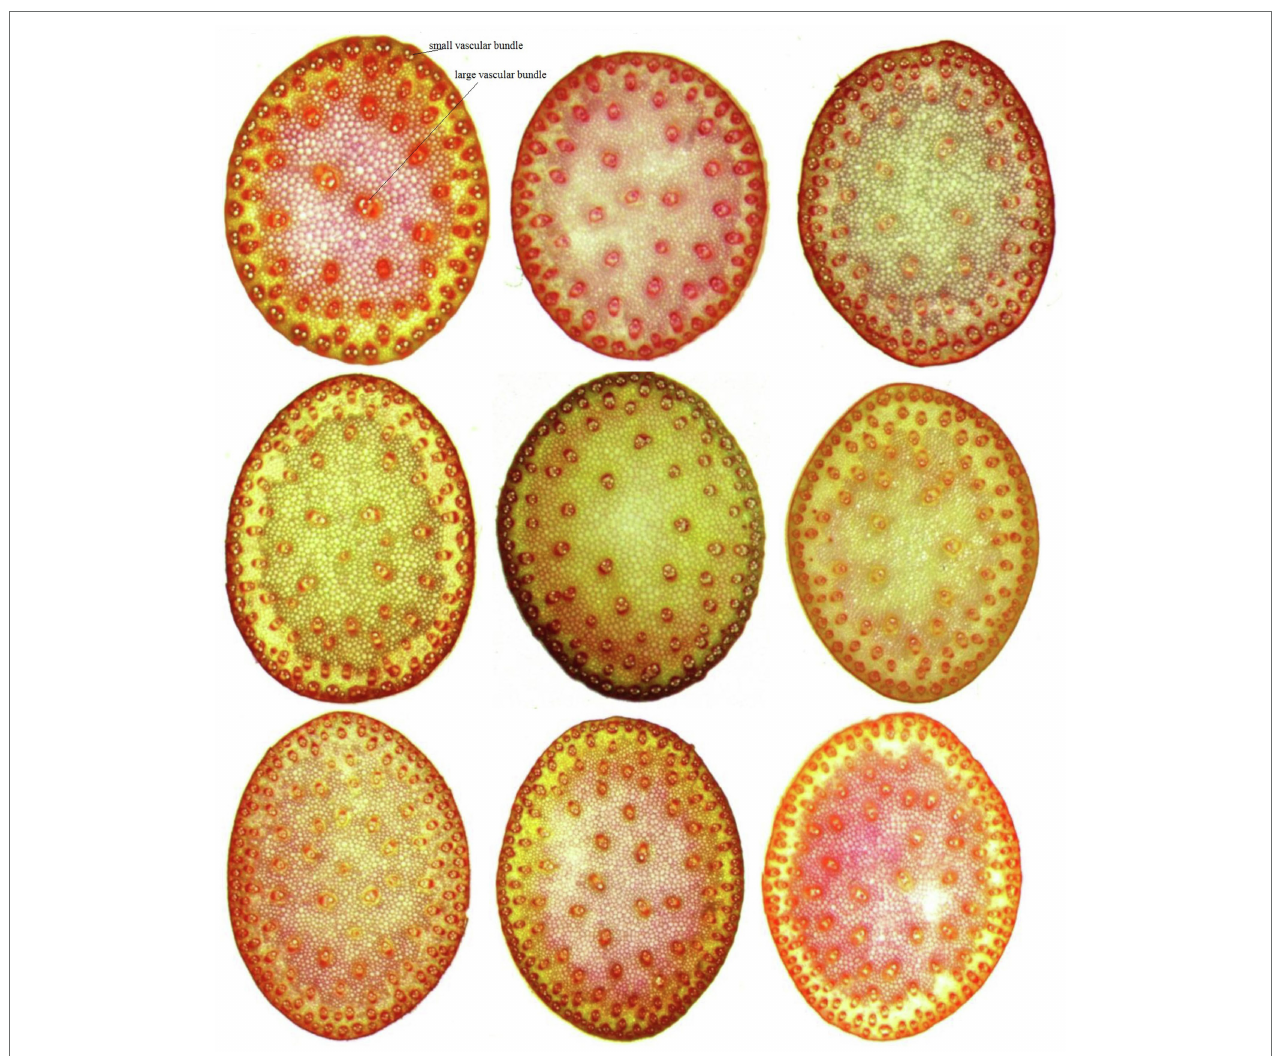
FIGURE 1 | Vascular bundle structure of different maize inbred